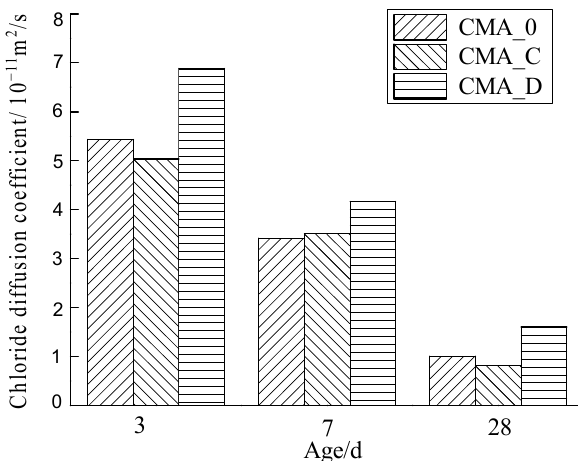
Figure 6. Chloride diffusion coefficient of concrete.